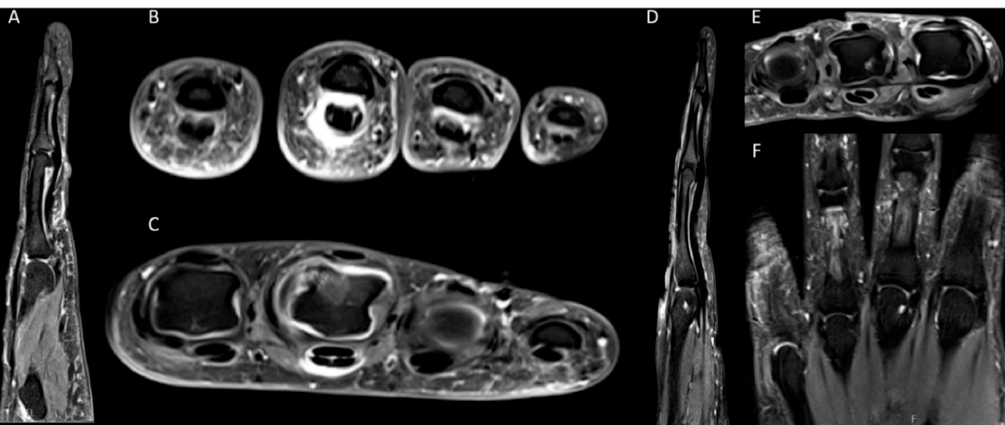
Figure 2. Representative MRI findings in a 57-year-old ( A – C ) and a 43-year-old ( D – F ) patient suffering from peripheral PsA. ( A ) and ( D ) Sagittal proton density-weighted (PD) fat-saturated (fs) image of the fourth ( A ) and third ( D ) digit ( B , C , E ) Transversal T1-weighted (T1w) fs image after contrast agent application through the level of proximal interphalangeal (PIP) joints of digits 2–5 ( B ), metacarpophalangeal (MCP) joints of digits 2–5 ( D ) and digits 2–4 ( E ). ( F ) Coronal short tau inversion recovery (STIR) sequence of the MCP joints of the digits 2–5 and the PIP joints of the digits 3 and 4. ( A , B ) show distinct periarticular inflammation and flexor tenosynovitis at the PIP joints of digits 3 and 4 and less distinct of the seconds digit. ( C ) illustrates synovitis, flexor tenosynovitis, bone marrow edema and a subtle erosion of the MCP joint of the third digit and moderate periarticular inflammation at the dorsal portion of the MCP joint of the fourth and at the palmar portion of the fifth digit. D-F depict a distinct bone erosion at the MCP joint of the third digit and periarticular inflammation at the MCP joints of the digits 2–4.